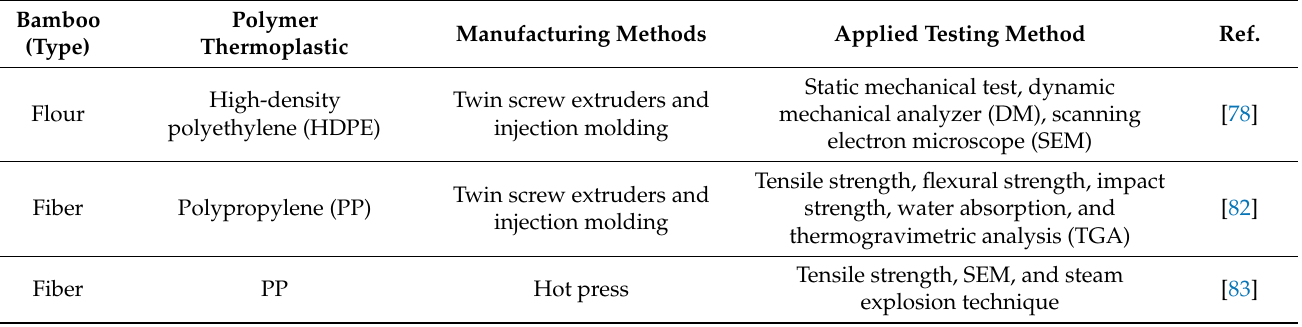
Table 6. Bamboo-reinforced polymer thermoplastic composites and testing